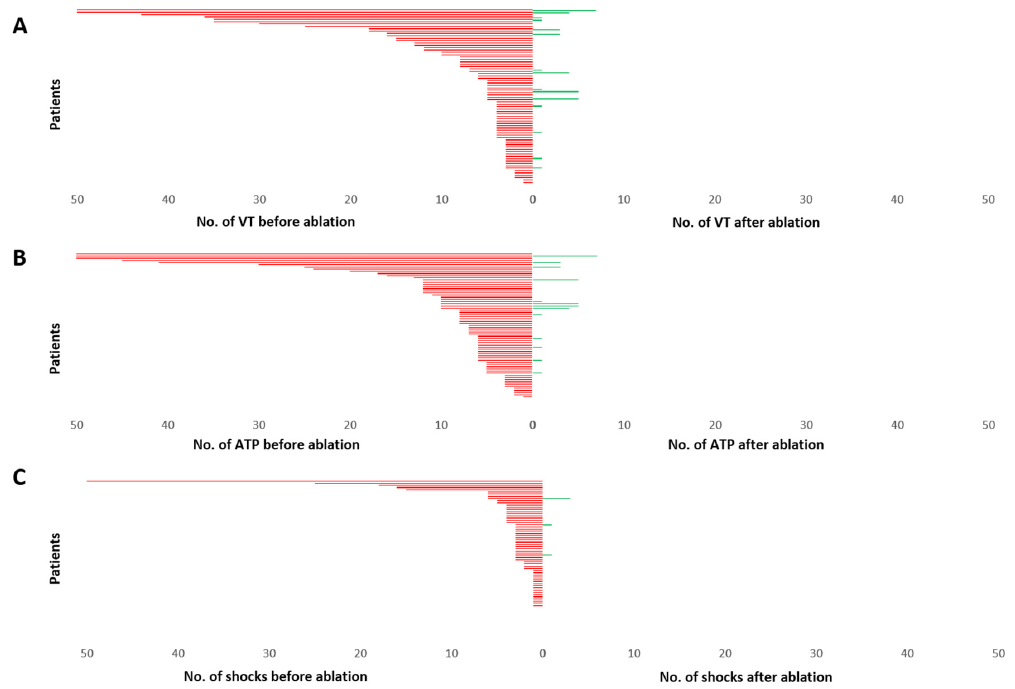
Figure 5. Burden of VA ( A ), ATP ( B ) and ICD shock delivery ( C ), displayed for each patient during 6 months before ablation and 6 months after ablation. Each patient is represented by a single line arranged from highest number of episodes to lowest. The upper values for events have been cut at 50. A significant reduction in mean number of VA, ATP and ICD shocks could be observed. VT—ventricular tachycardia; ATP—anti-tachycardia pacing; No.—number.